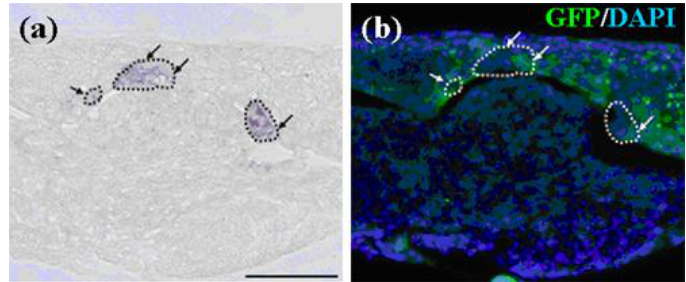
Figure 6. Shh expression in germs reconstructed with emtg-2 cells and EC (1:0.5) and MT and cultured for three days. ( a ) Shh expression ( in-situ hybridization) was encircled with broken lines and pointed with arrows. ( b ) Immunohistochemistry with anti-GFP antibody localized emtg-2 cells (green) in the serial section, overlapping Shh expression. Scale bar is (cid:20)(cid:19)(cid:19)(cid:3)(cid:541)(cid:80)(cid:3)(cid:68)(cid:81)(cid:71)(cid:3)(cid:11) b ) is at the same